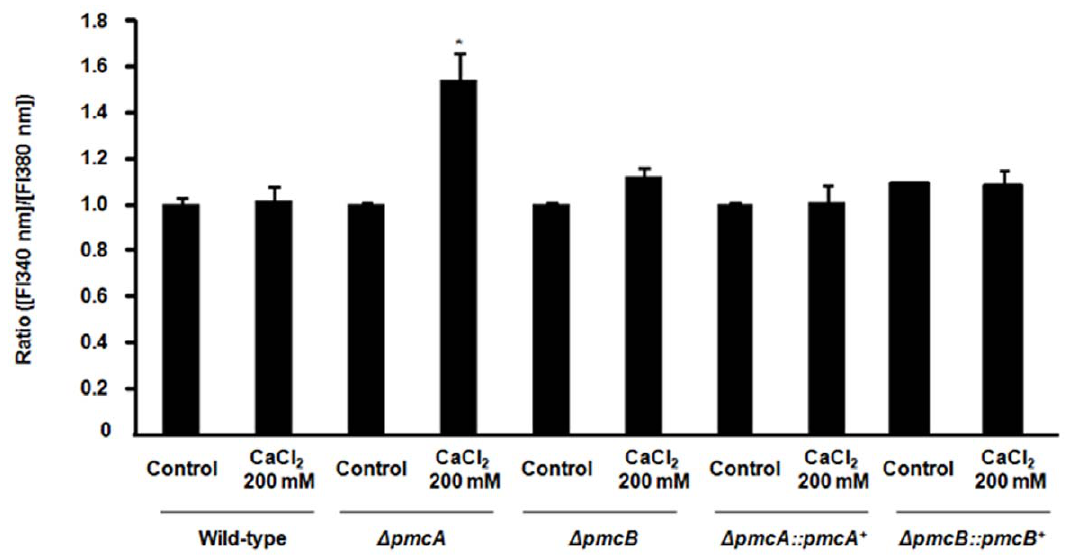
Figure 8. The D pmcA mutant strain has increased accumulation of calcium in the cytoplasm. The relative levels of intracellular calcium in the wild-type, D pmcA and D pmcB mutant strains were determined using the calcium-sensitive dye Fura-2-AM. The relative Ca + 2 concentration was determined based on the fluorescence ratio after dual-wavelength excitation (fluorescent intensity at 340 nm [FI340 nm]/[FI380 nm]. Data shown are means of three repetitions 6 standard deviations. Statistical analysis was performed by using either One-Way Anova with Newman-Keuls post-tests or Tukey’s multiple comparison tests. * p , 0.005.